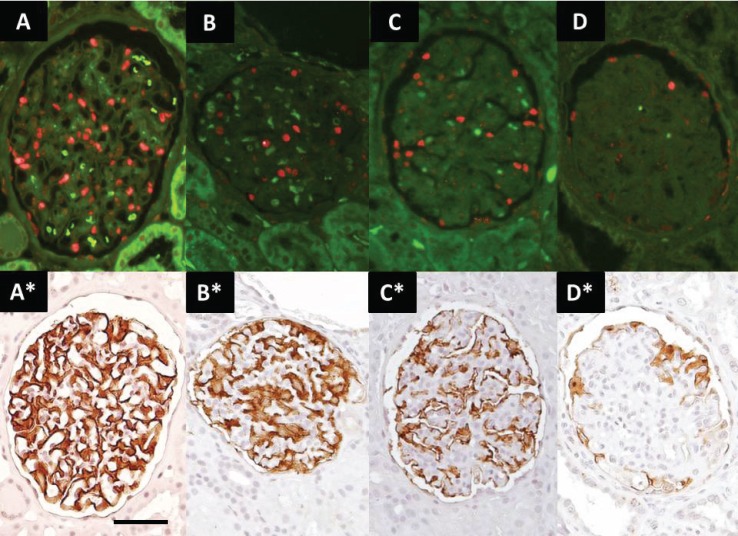
Identification of podocyte nuclei and cells in ASC biopsies.Upper panels show podocyte nuclei (red) identified by TLE4 immunofluoresce. Lower panels show Glepp1 immunoperoxidase (brown) in the same sections. Panels A and A* shows a normal glomerulus. Panels B to D and B* to D* show glomeruli with progressively reduced numbers of podocytes and Glepp1 peroxidase positive area (as a % of the glomerular area) representing progressive glomerular injury associated with AS. Parietal podocytes are excluded from analysis by delineating the area of interest using software so that the podocyte nuclear count and Glepp1 area quantitation is for the tuft area only. Magnification is the same for all panels where the bar shown represents 50um.